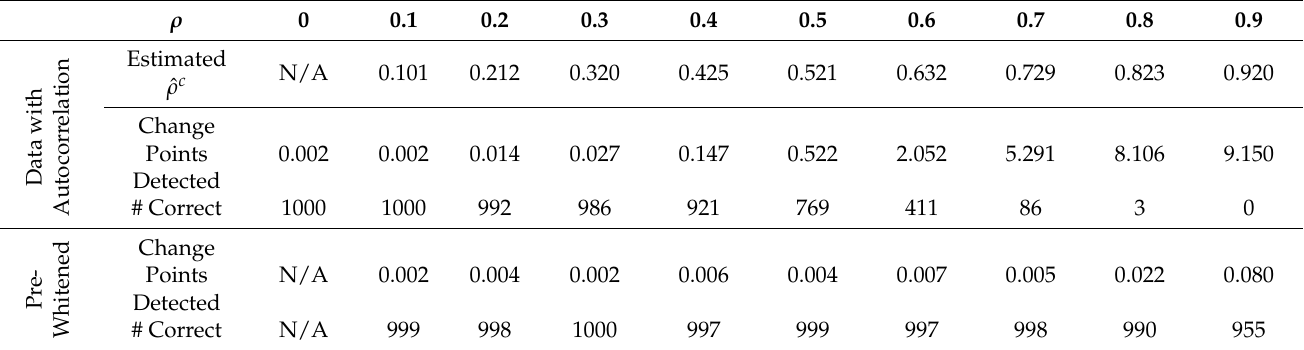
Table 1. Autocorrelation in a Constant Model. A total of 1000 datasets were generated for each value of the autocorrelation parameter, ρ . The average number of change points detected by the Bayesian change point model before and after pre-whitening is indicated for each value of ρ in addition to the number of datasets (out of 1000) where the algorithm correctly identified zero change points (i.e., the number of datasets where the expected number of change points < 0.5). Note that a value of ρ = 0 corresponds to white